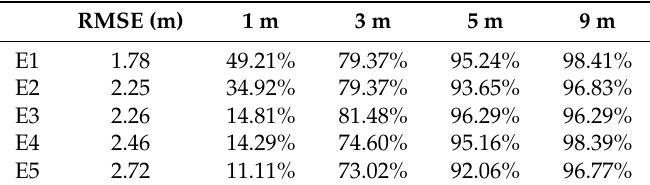
Table 6. Localization results in different obstacle environments: E1 (General Crowds Area), E2 (Light